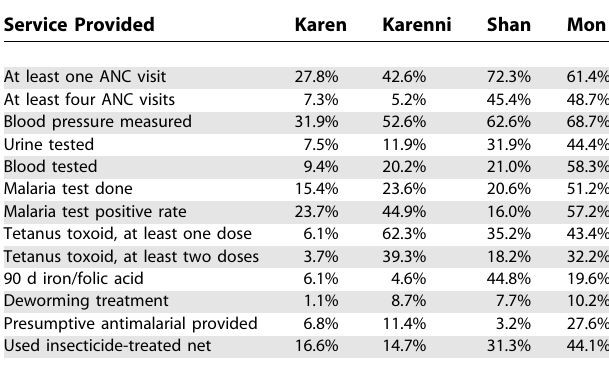
Table 2. Antenatal Care Services in Last Reported Pregnancy by